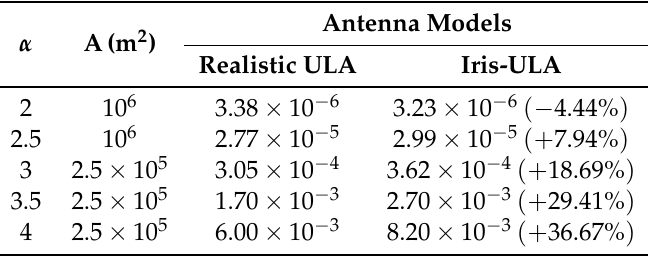
Table 8. Critical node density ρ c with the ULA antenna and the iris-ULA model when σ = 8.